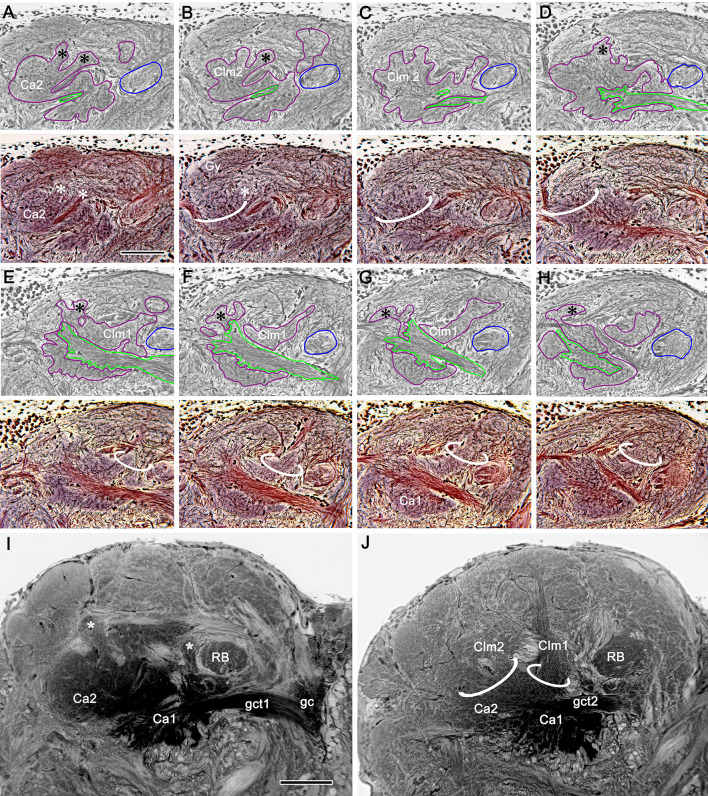
The interface between columns and gyri.(A–H) Paired half-tone/color micrographs of selected levels of a silver-stained, serially sectioned RLPR (medial to the left, rostral upwards). Green outlines in panels A-D indicate parts of the globuli cell tract (gct2) to calyx 2 (Ca2); in E-H, parts of the gct1 to calyx 1 (Ca1). Blue outlines indicate cross sections of the reniform body pedestal (RB); magenta outlines indicate mushroom bodies (calyces and their columns). Identification of the calyces is enabled by their color and microglomeruli as in Ca2, (lower panel A). As in osmium-ethyl gallate sections, the two calyces are too close to identify separately unless viewed downwards from the rostral surface of the LPR. Columns (ringed) and smaller finger-like extensions (asterisks) extend outwards to the gyri. Column 2 (Clm2) from calyx 2 (Ca2) is shown in panels A-D. Panels E-H illustrate the origin and width of Clm1 from Ca1. Panels I and J show corresponding arrangements revealed by osmium-ethyl gallate. Scale bars, 100 μm.